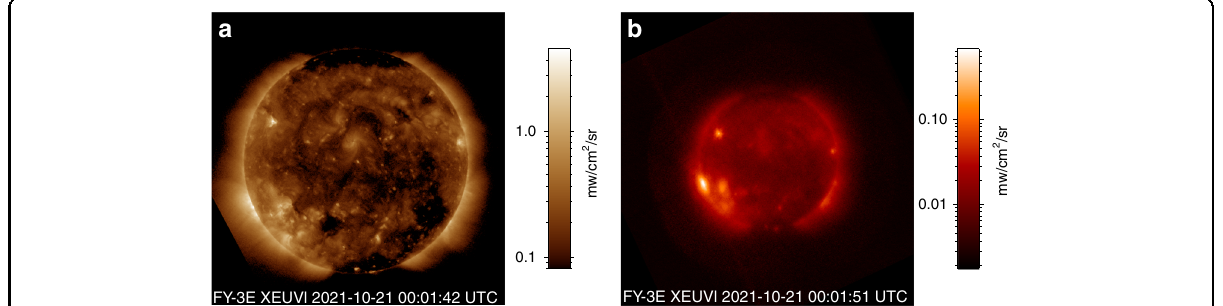
Fig. 1 The solar images captured by X-EUVI. a image in the 19.5 nm region. b image in the 0.6 – 8.0 nm